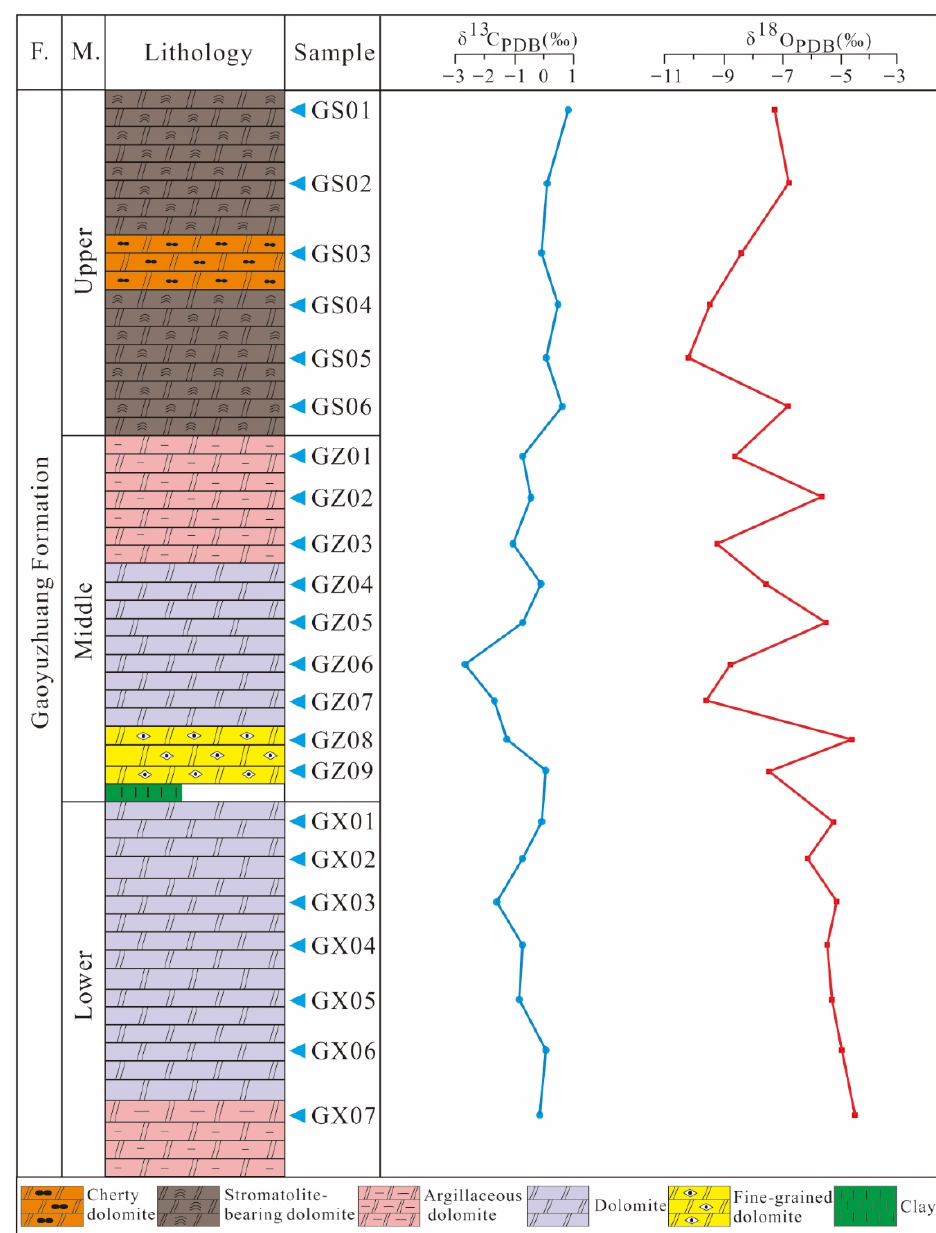
Figure 9. Vertical δ 13 C and δ 18 O profiles of the carbonate rocks from the Gaoyuzhuang